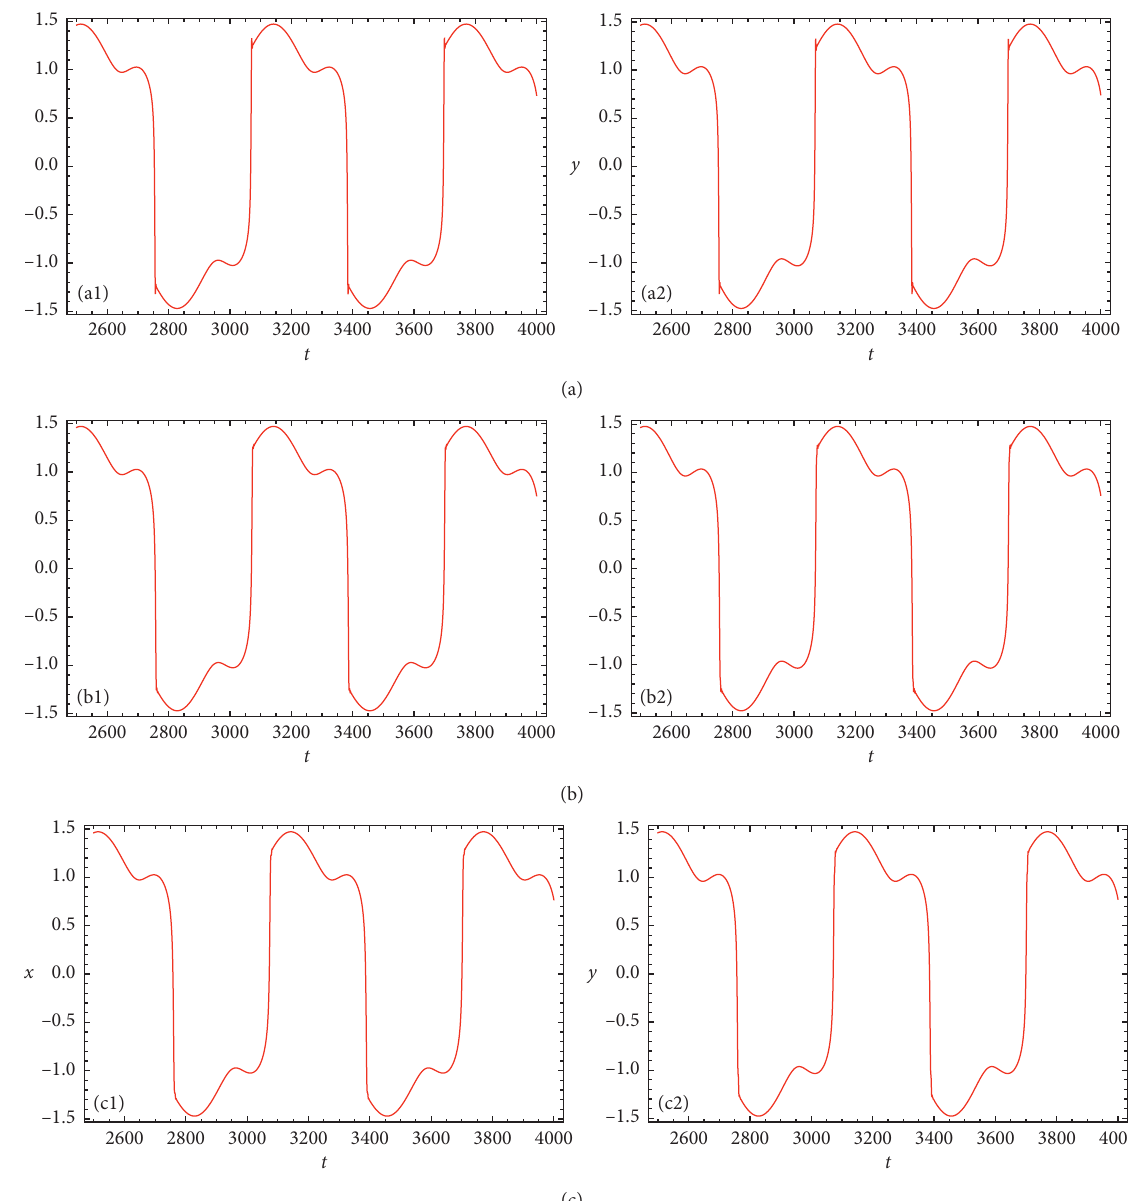
Figure 8: Time series of the bursting for δ and ( c